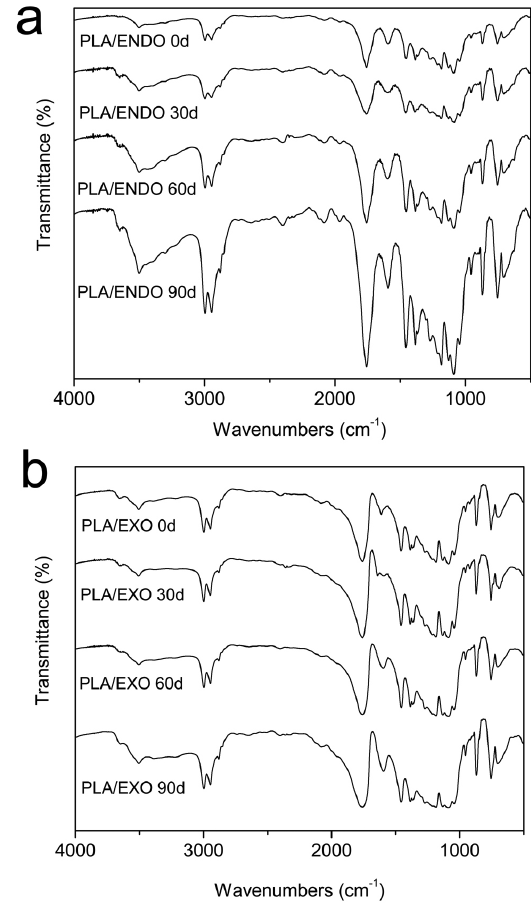
Figure 4. FTIR spectra of (a) E-PLA/ENDO and (b) E-PLA/EXO as a function of the exposure time in simulated